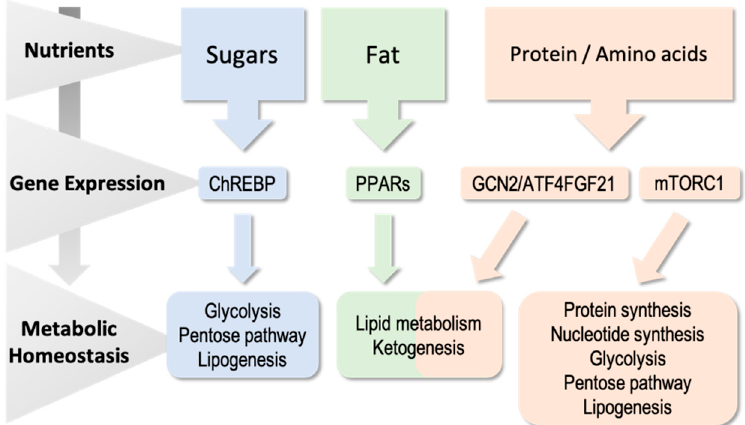
Figure 1. Mammals detect an abundance of nutrients such as sugars, fat and amino acids, and provide a metabolic response most times through the control of gene expression (from transcription to translation). Sugars signaling mainly goes through the carbohydrate-responsive element binding protein (ChREBP). Peroxisome proliferator-activated receptors (PPARs) are the responsible response to fat, and the GCN2/activating transcription factor 4 (ATF4) and mTORC1 pathways sense amino acid concentrations.